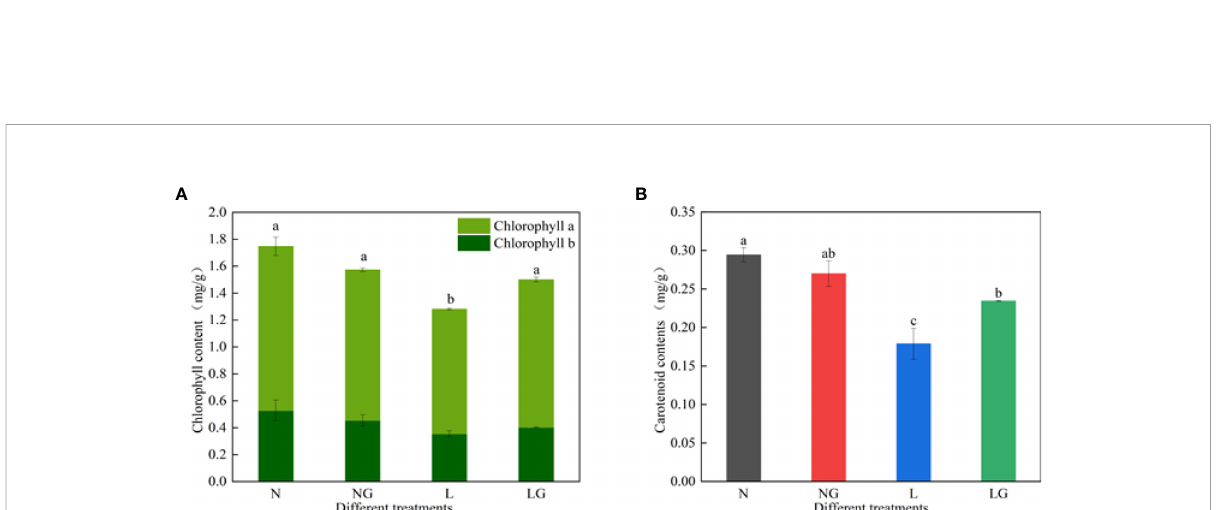
FIGURE 6 Effects of GABA spraying on photosynthetic pigment contents in M. ruthenica seedlings at normal and low temperatures. (A) Chlorophyll a and chlorophyll b content in leaves; (B) carotenoid content in leaves. N, the plant pretreated with distilled water and grown at normal temperature. NG, the plant pretreated with GABA and grown at normal temperature. L, the plant pretreated with distilled water and grown at low temperature. LG, the plant pretreated with GABA and grown at low temperature. Different lowercase letters indicate signi fi cant differences between treatments ( P <